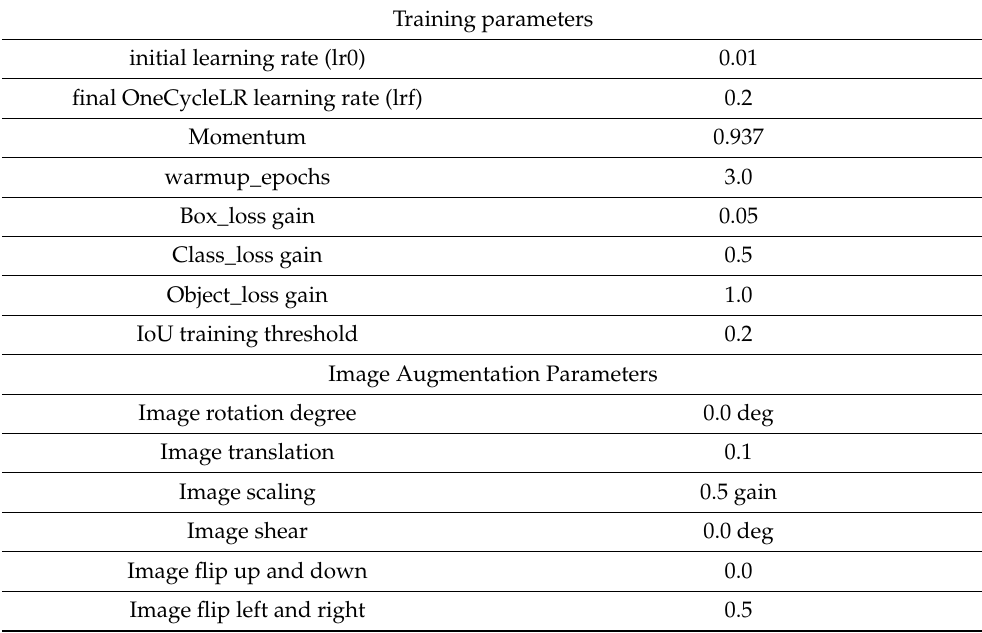
Table 1. The default training parameters for the YOLO